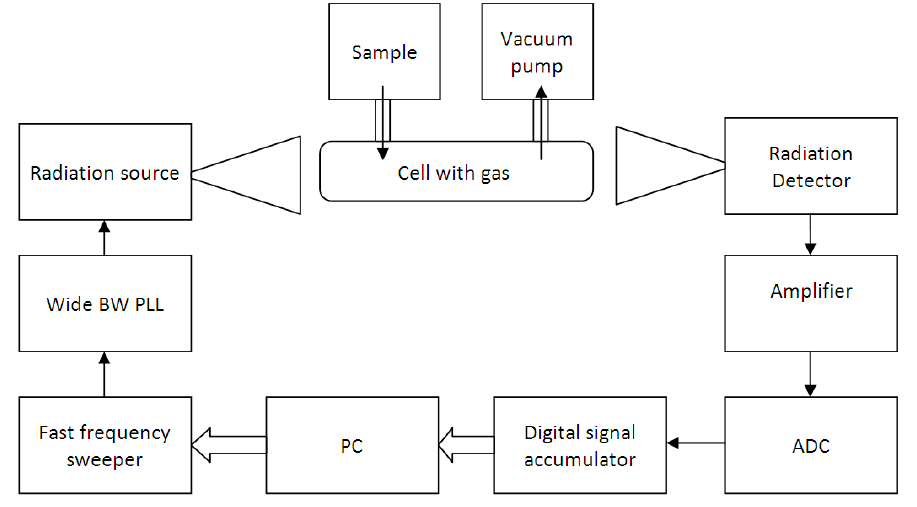
Figure 2. Frequency sweep spectrometer.